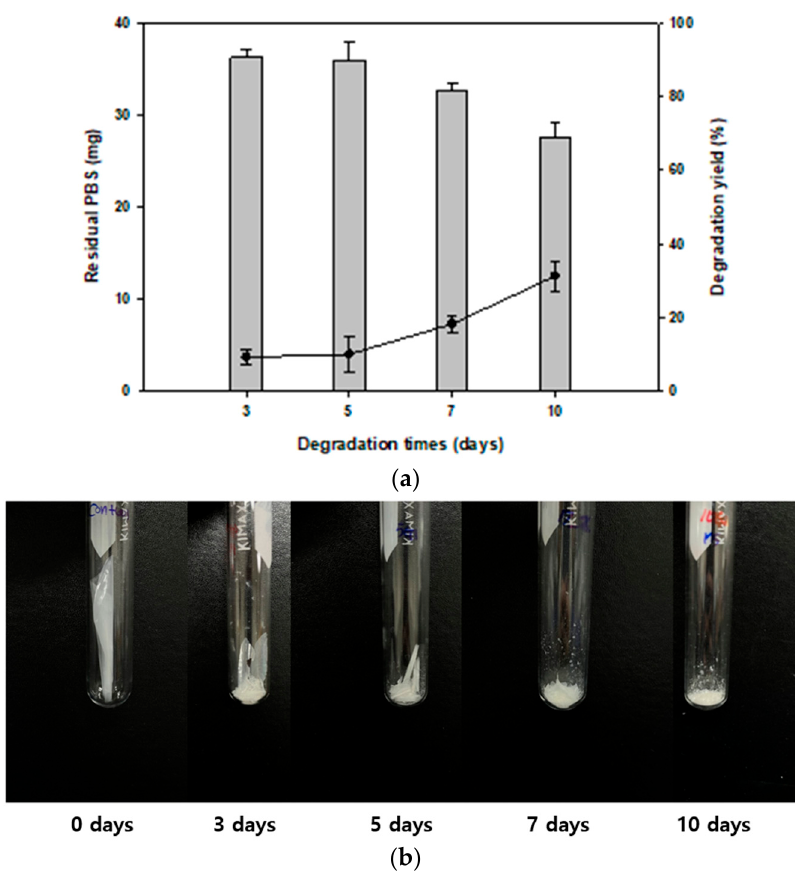
Figure 4. Confirming the degree of PBS degradation based on cultivation period ( a ) Residual amount of PBS and degradation yield was confirmed using GC-MS. ( b ) Recovered PBS films after lyophilization. The amount of PBS films decreased, and the films fragmented with